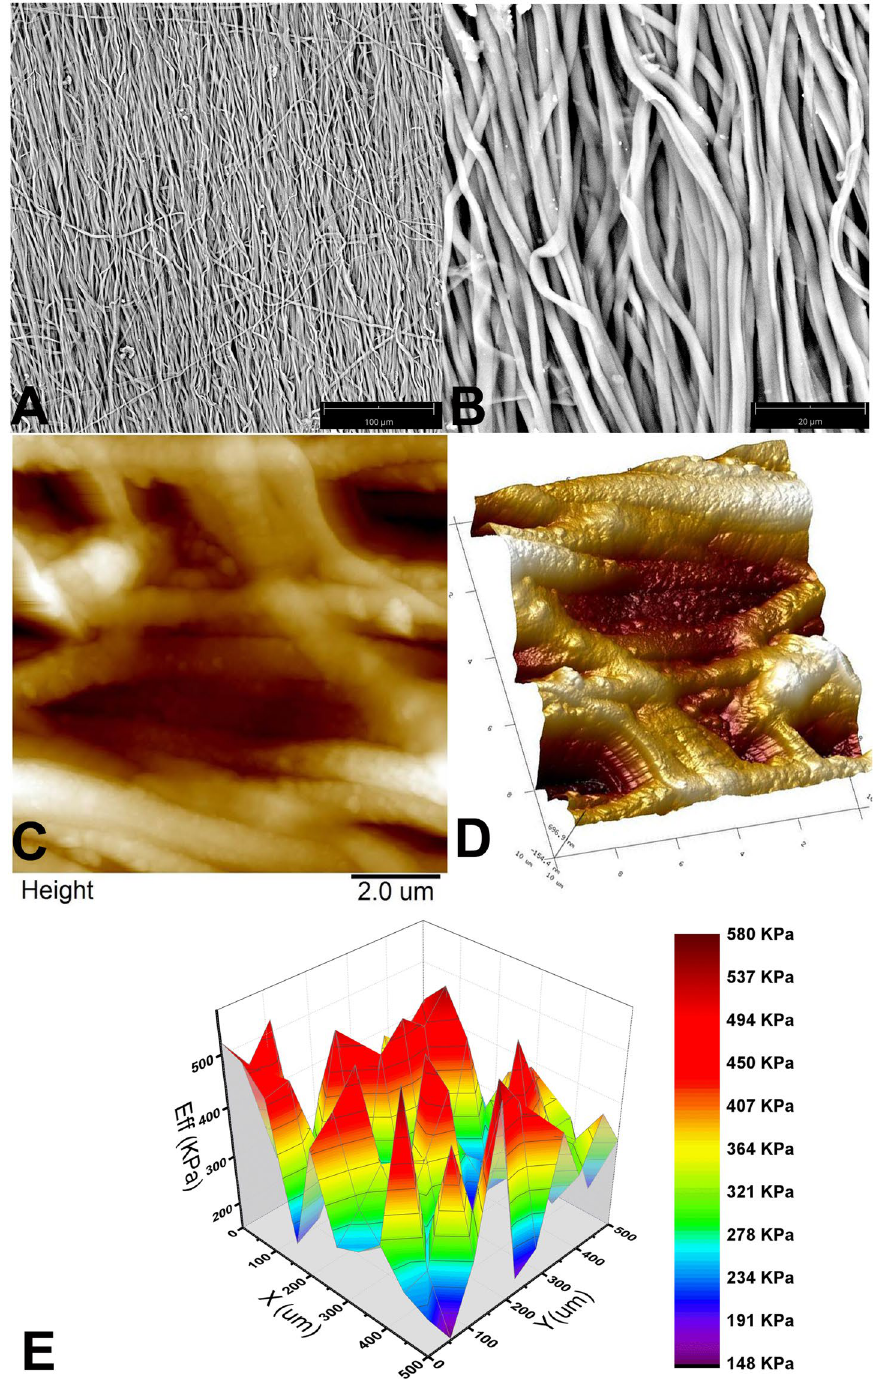
Figure 3. The spatial architecture and mechanical properties of the rSS-PCL scaffold: ( A , B ) SEM images, ( C ), 2D and ( D ), 3D – atomic force microscopy images, ( E ). typical Young’s modulus distribution obtained by